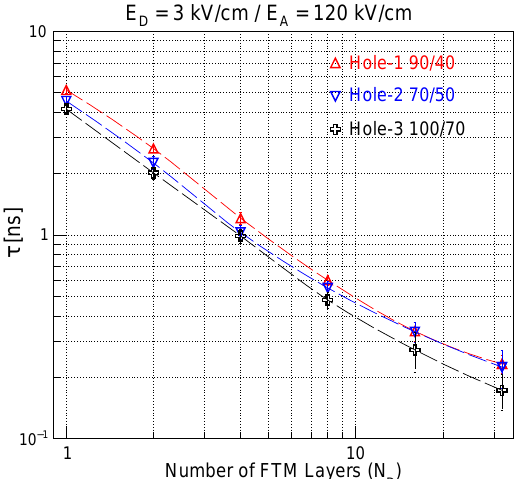
Figure 4. Time resolutions vs. N D . For a 32-layers FTM, a time resolution of 173 ps is obtained with hole-3 in Ar/CO 2 (70/30), ∼ 30% better than both other